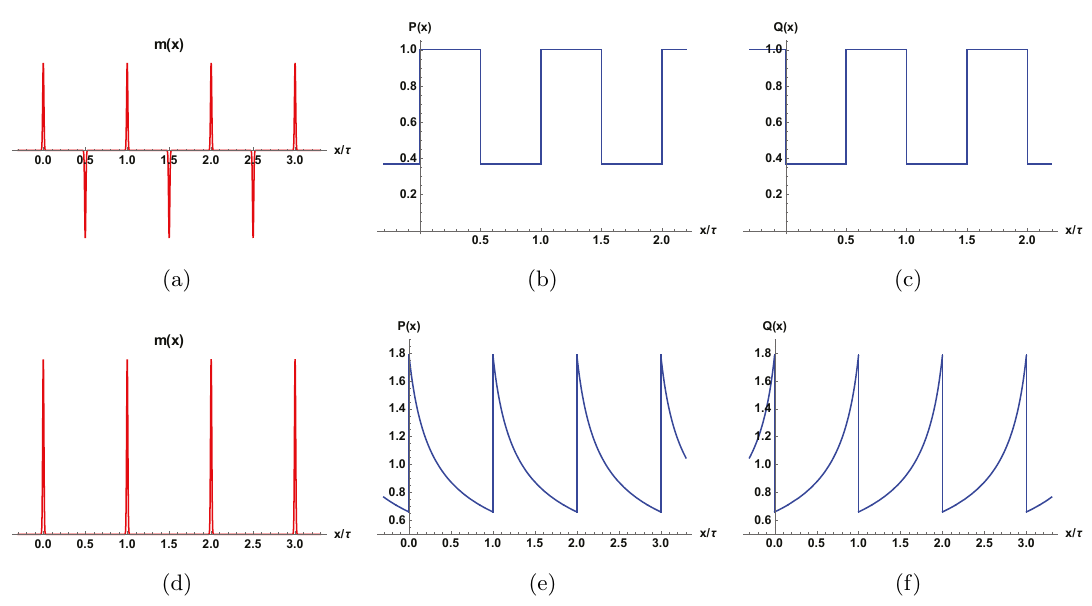
Figure 4 . Various vacuum con(cid:12)gurations of delta function arrays: (a) is a cartoon for the mass- function (B.16) and (b) and (c) are the corresponding warping factors to the diagonal matrices in (B.17). (d) depicts the mass-function (B.18). In addition (e) and (f) show the warping factors given by